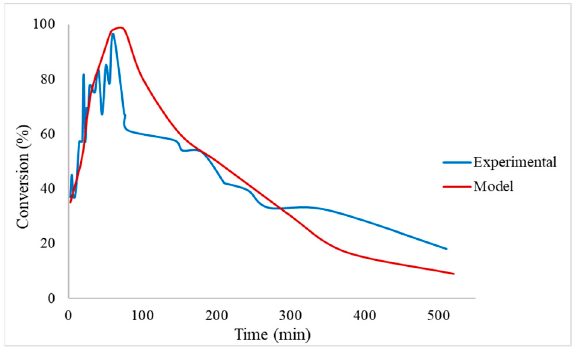
Figure 1. Comparison between experimental data and CFD modelling results. Reaction conditions: temperature = 30 °C; pressure = 1 bar; inlet flow = 0.05 mL/min; 0.1g catalyst of 5 wt.% Pd on Carbon.